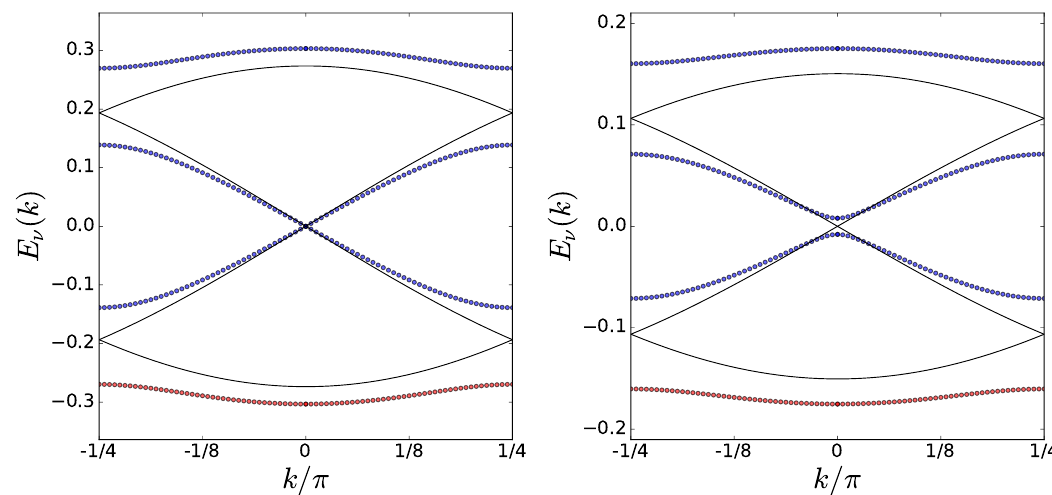
Figure 12: Band structure of the commensurate CDW at quarter filling (filled band showed with red points) for the integrable case λ = 2 (left) and nonintegrable case λ = 1.6 (right). The gap at E = 0 opens when λ < 2 and the CDW gets pinned. = 0. The black lines are the band structure for the uniform Here, p = 0.02, ξ = 2, ξ 4 structure with the same averaged length (metallic state), for comparison: not only the Peierls gap opens at the Fermi energy but all energy levels are